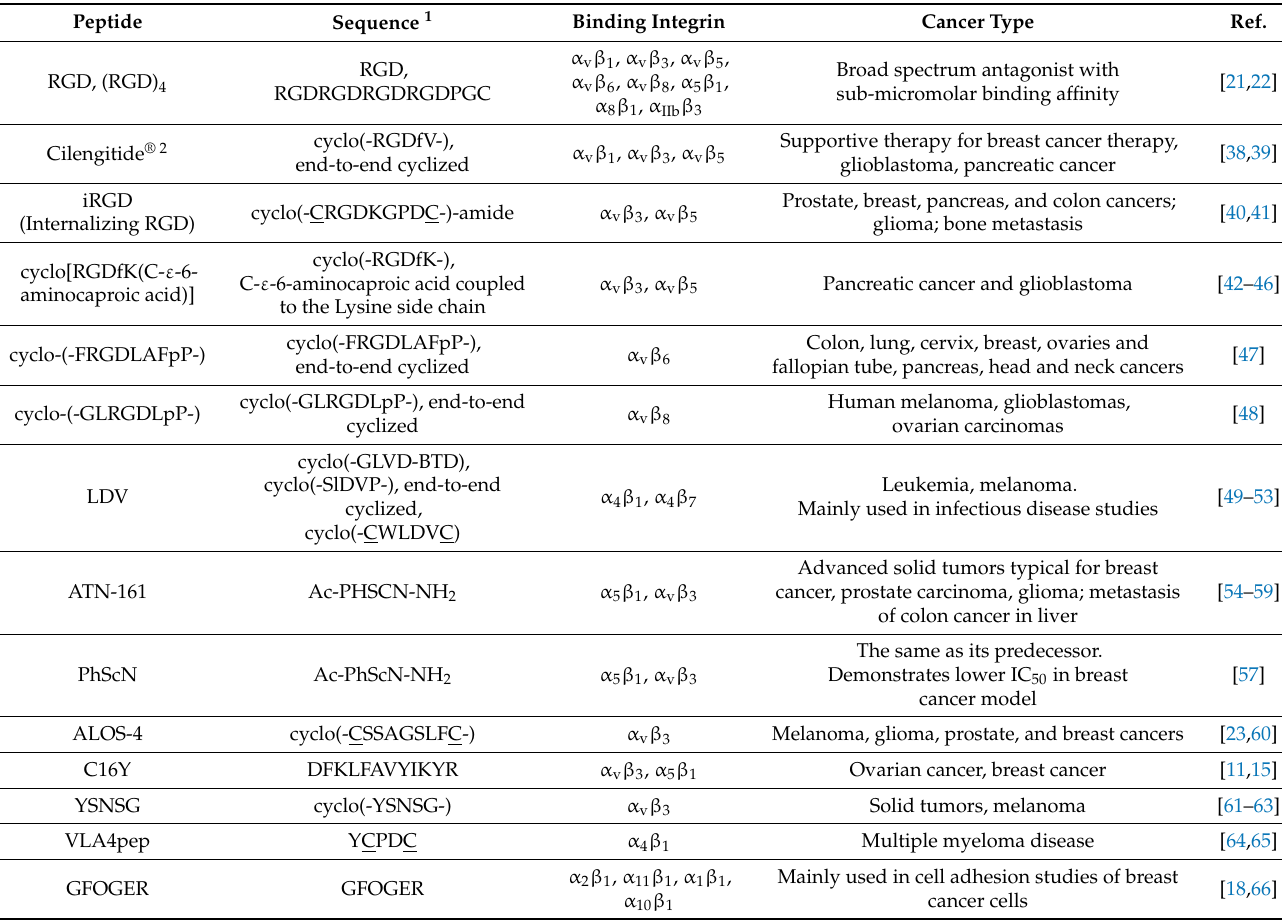
Table 1. Knownintegrin-targetingpeptides andtheirrelationto integrintargetsanddifferentcancer types. Peptide Sequence 1 Binding Integrin Cancer Type